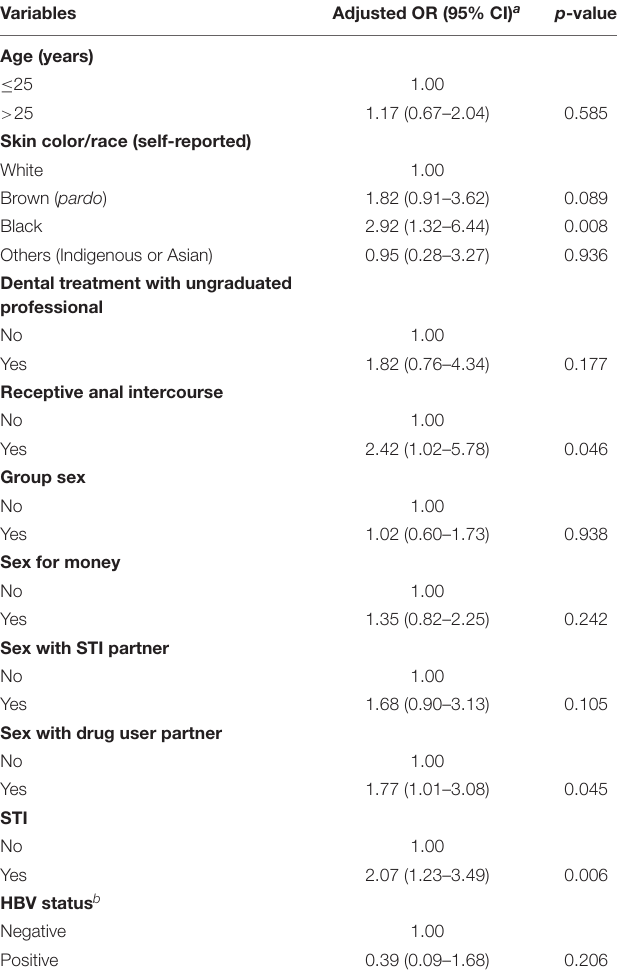
TABLE 3 | Multivariate analysis of factors associated with HIV-1 infection among MSM from Goiânia, Central-Western Brazil.